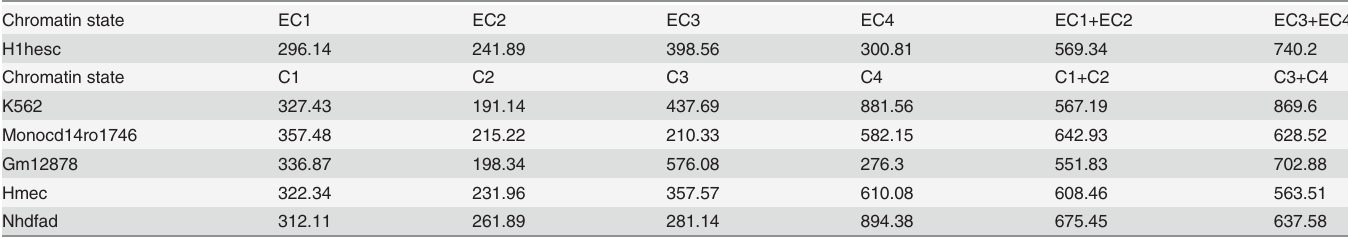
Table 3. Mean length of chromatin state blocks per chromatin state in kb (Materials and Methods) in ES H1hesc and differentiated cells (see Table